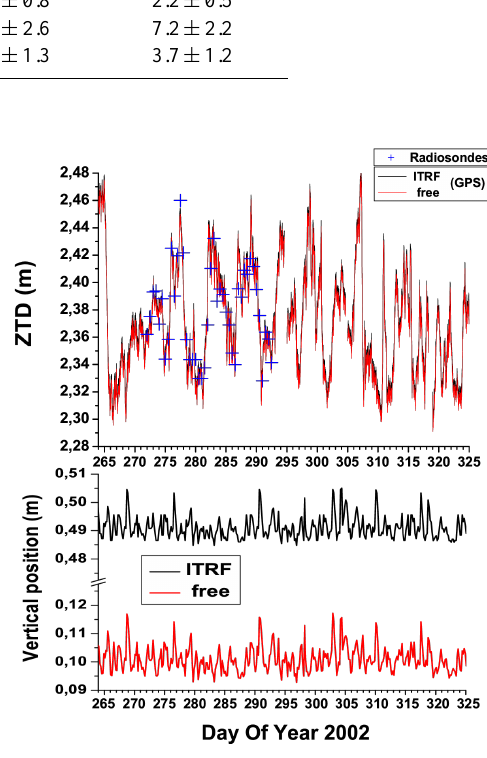
Fig. 5. Time series of ZTD and vertical position estimates for station CDGA over 61 days (from DOY 264 to DOY 325 of 2002), in a free and an ITRF reference frame (red and black lines, respectively). Equivalent ZTD from RS data from the Nîmes station (from DOY 272 to DOY 293 of 2002), represented by crosses, are superposed to the CDGA ZTD solutions. Vertical positions are estimated considering the altitude difference with the Earth centre of WGS84 at 6368137 m.